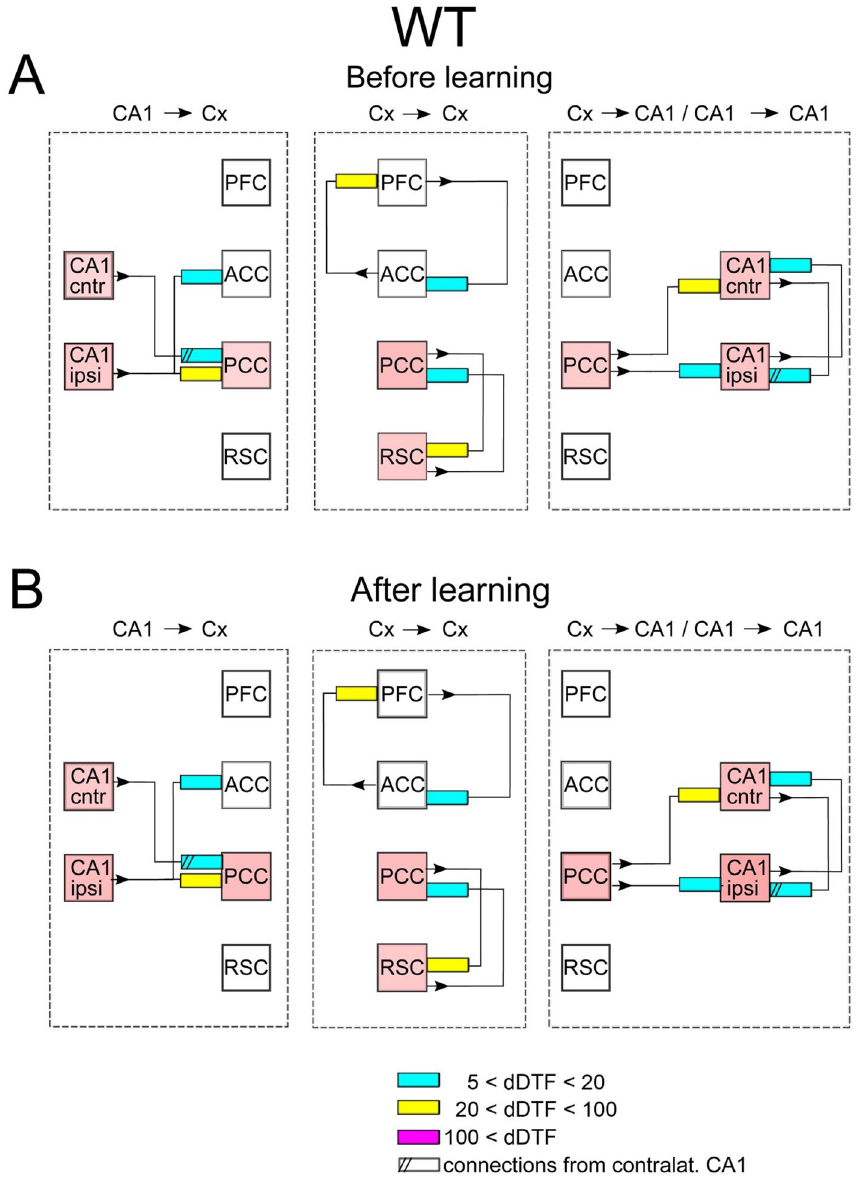
Figure 2. Scheme of interaction between brain structures in WT mice in the absence of SWRs. Shown are connections expressed before and after learning. The mean strength of the interactions within the group (in arbitrary units) is coded by colors of rectangles pointing out to the target structures; see the insert in the figure. The numbers in the insert correspond to dDTF values integrated over 20–50 Hz multiplied by 10 5 . Pink color marked structures involved in hippocampal–cortical–hippocampal loop of transmission of slow gamma signals, here realized by: CA1 → PCC → RSC → PCC → CA1 transmission. Notice the disconnection of signals transmitted in the PFC → ACC → PFC loop from the main loop of